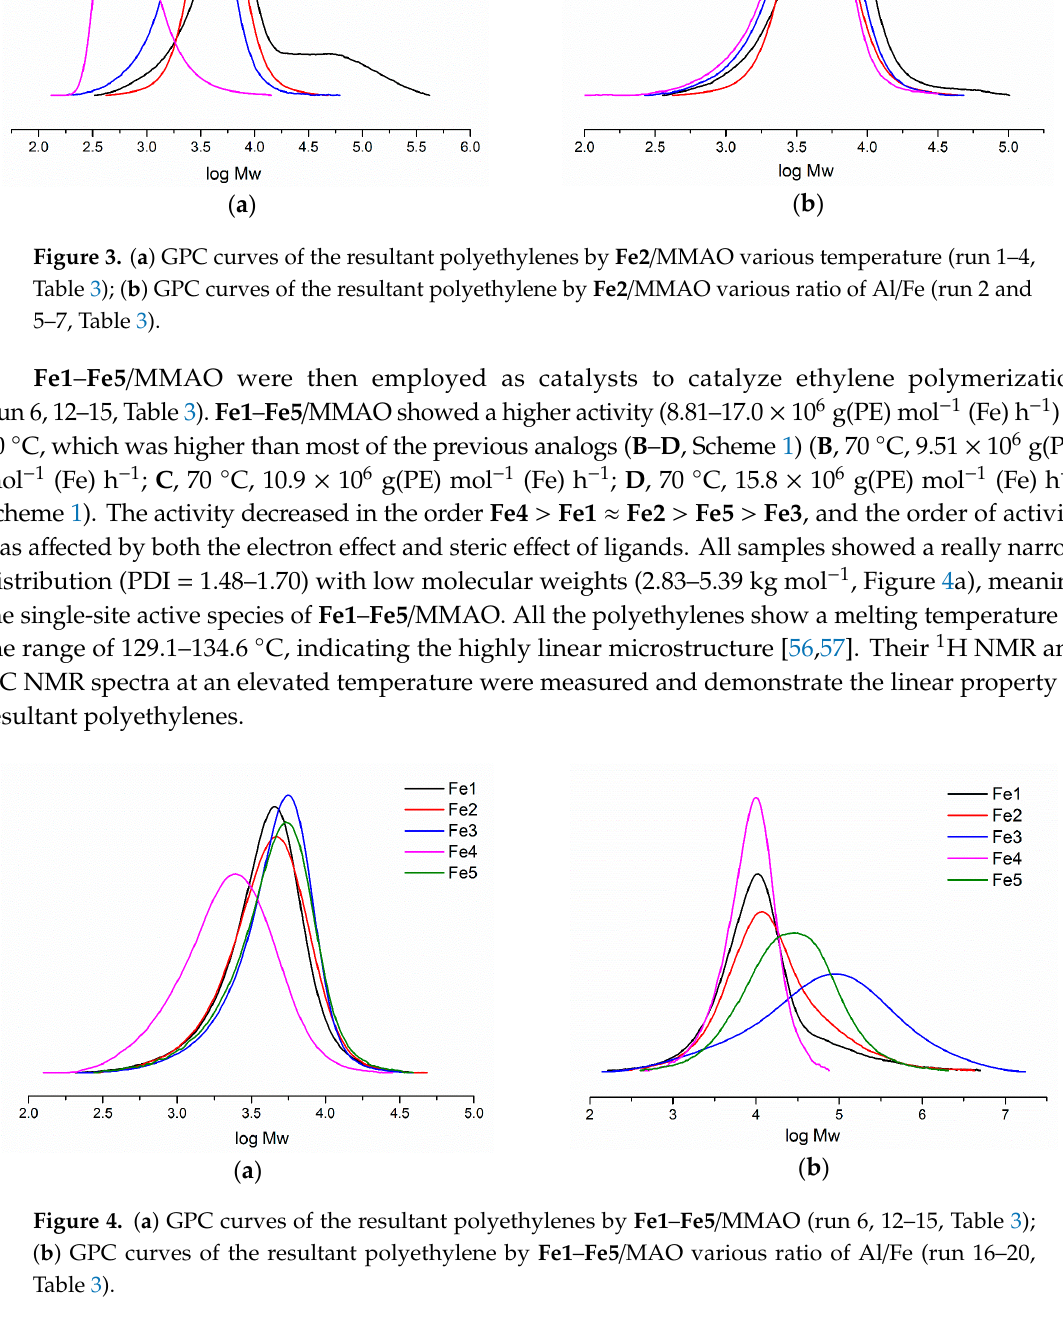
Figure 5. The NMR spectrum of polyethylenes obtained by Fe2 /MMAO at 70 °C (run 6, Table 3). The Fe1 – Fe5 /MAO system was also employed to further investigate the ethylene polymerization behavior (run 16–20, Table 3). The activity decreased in the order Fe4 > Fe2 > Fe5 > Fe1 > Fe3 (15.8–2.58 × 10 6 g(PE) mol − 1 (Fe) h − 1 ), and the molecular weight of polyethylenes decreased in the order Fe3 > Fe5 > Fe2 > Fe1 > Fe4 (291–10.7 kg mol − 1 ). Different than Fe1 – Fe5 /MMAO, the molecular weight of polyethylenes catalyzed by Fe1 – Fe5 /MAO was higher with a broader molecular